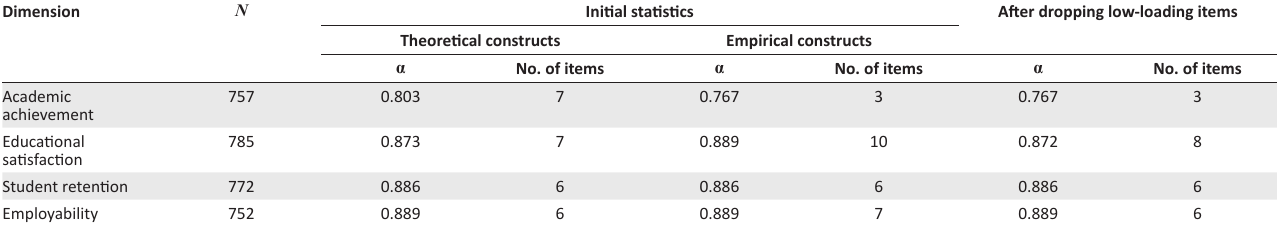
TABLE 8: Cronbach’s alpha ( α ) for student educational outcomes effectiveness questionnaire. Dimension N